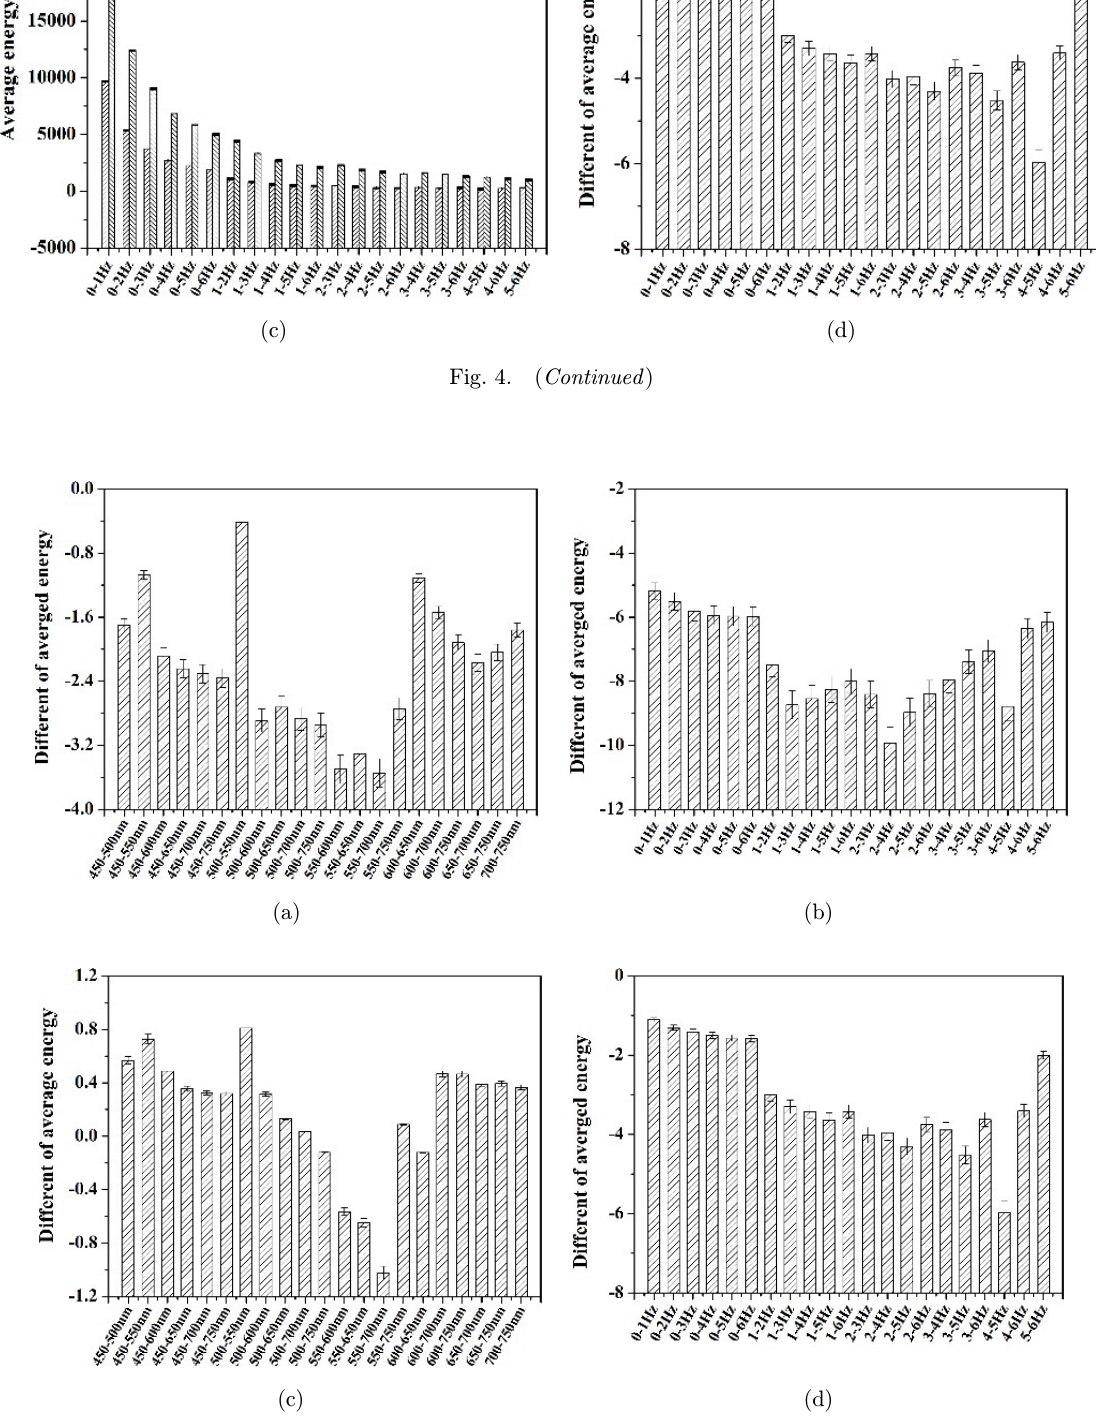
Fig. 5. Di®erences of average energy from di®erent band groups in cow and sheep vertebra experiment. (a) di®erent band groups in cow vertebra experiment, (b) di®erent frequency section after FFT changes in cow vertebra experiment (550 nm to 750 nm), (c) di®erent band groups in sheep vertebra experiment, (d) di®erent frequency section after FFT changes in sheep vertebra experiment (550 nm to 750